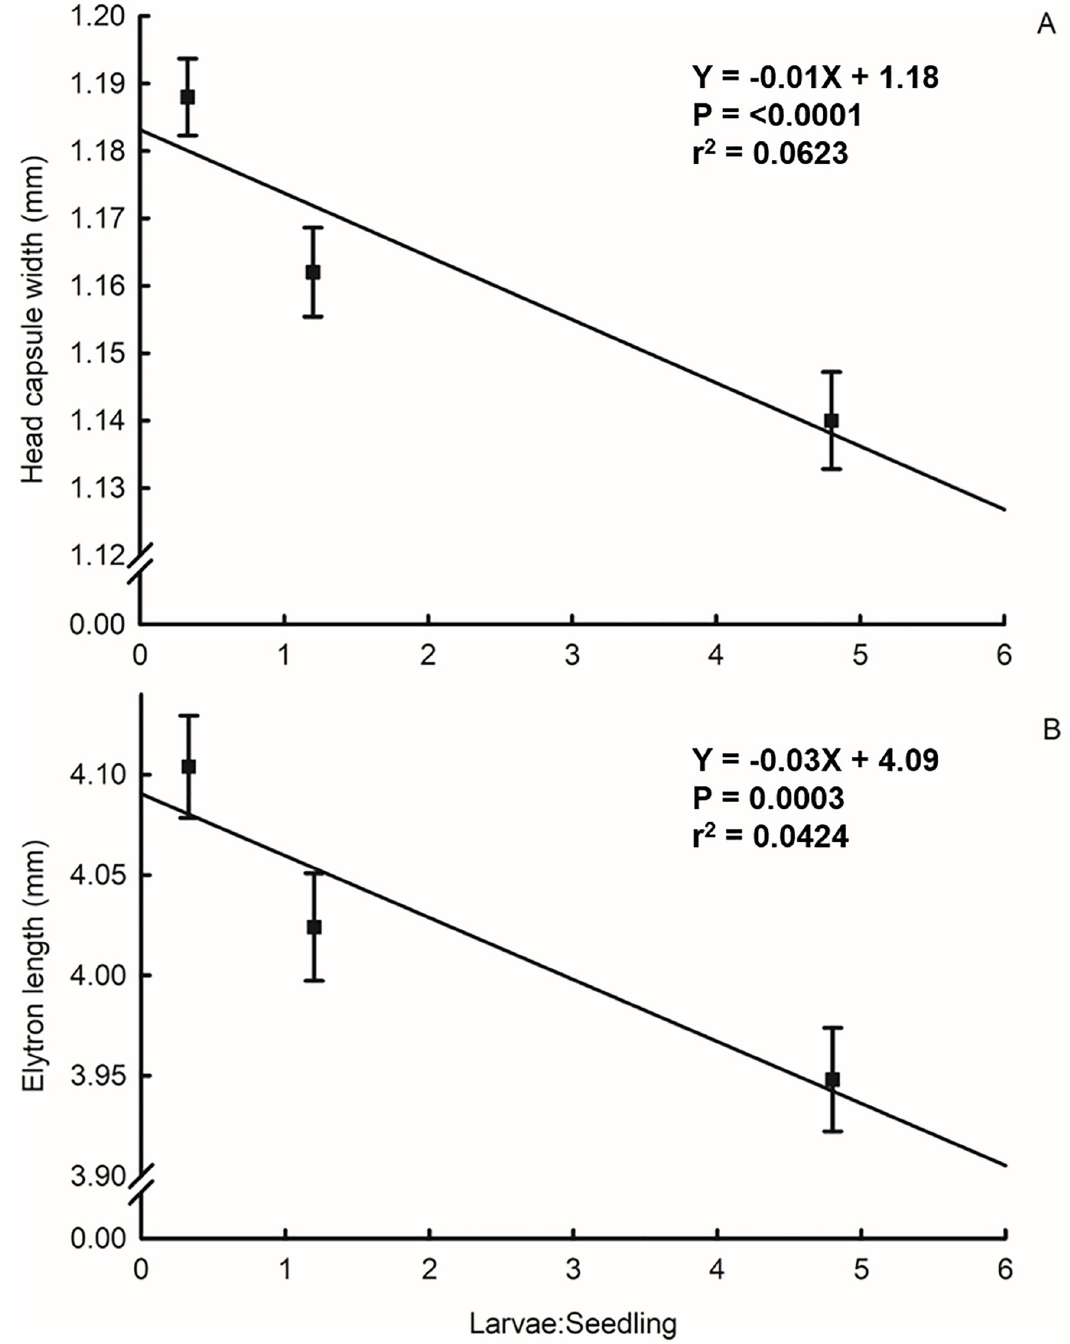
Fig 2. Size of western corn rootworm adults reared at different larval densities measured by (A) head capsule width, and (B) elytron length. Points represent sample means, and error bars indicate SEM. Linear regression analyses were conducted with raw data. Linear regression of morphological measurements (Y) on larval density (X): (A) df = 1, 305, Y = -0.01X + 1.18, t = -4.50, P < 0.0001, r 2 = 0.0623; (B) df = 1, 305, Y = -0.03X + 4.09, t = -3.68, P = 0.0003, r 2 = 0.0424.